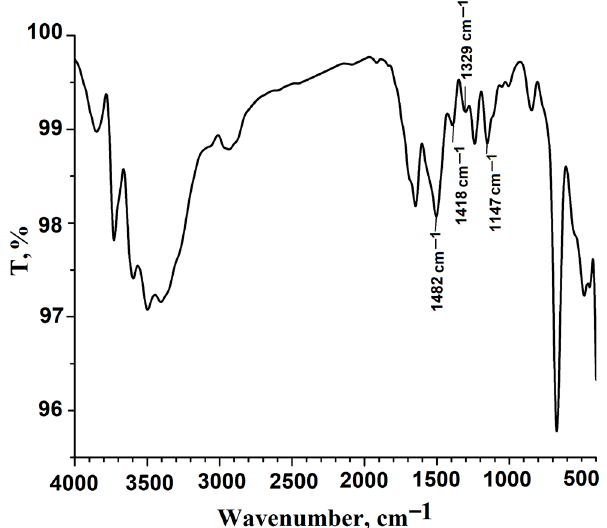
Figure 3. FTIR spectrum of polysulfone functionalized with triethylphosphonium groups.